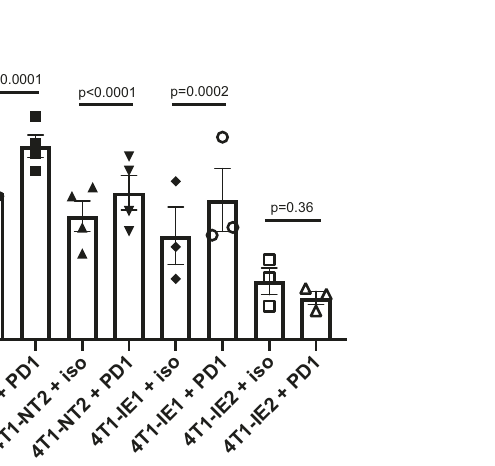
mean±SEM. B Measurement of intracellular IFN-gamma production by 4T1- speci fi c CD8+T cells following co-culture with clonal 4T1 populations with or without anti-PD1 (PD1) or anisotypecontrol (iso). Three biologicalreplicates in IE1 and IE2 groups and four biological replicates in NT1 and NT2 groups. P value calculated using fl ow cytometry proportions fi tted to a GLM with Bonferroni